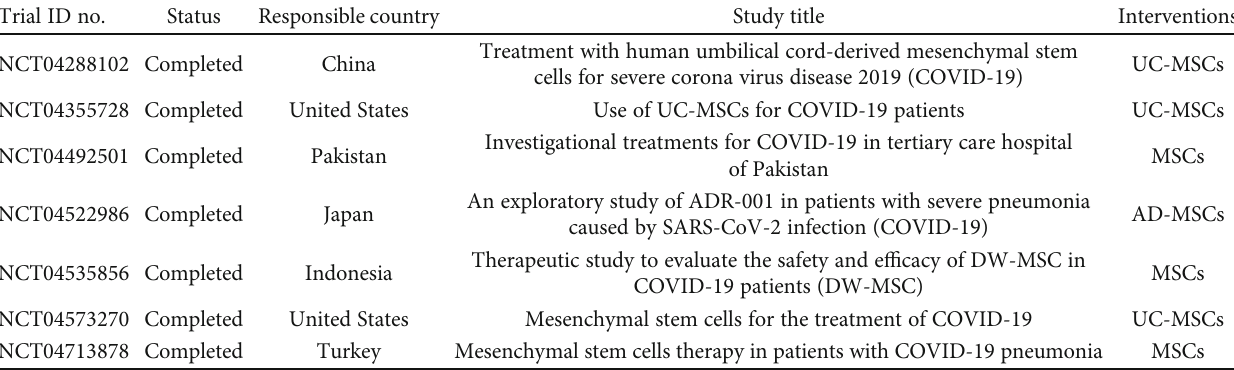
Table 1: Clinical trials investigated the use of MSCs for COVID-19 treatment marked “ completed ” on clinicaltrials.gov. Trial ID